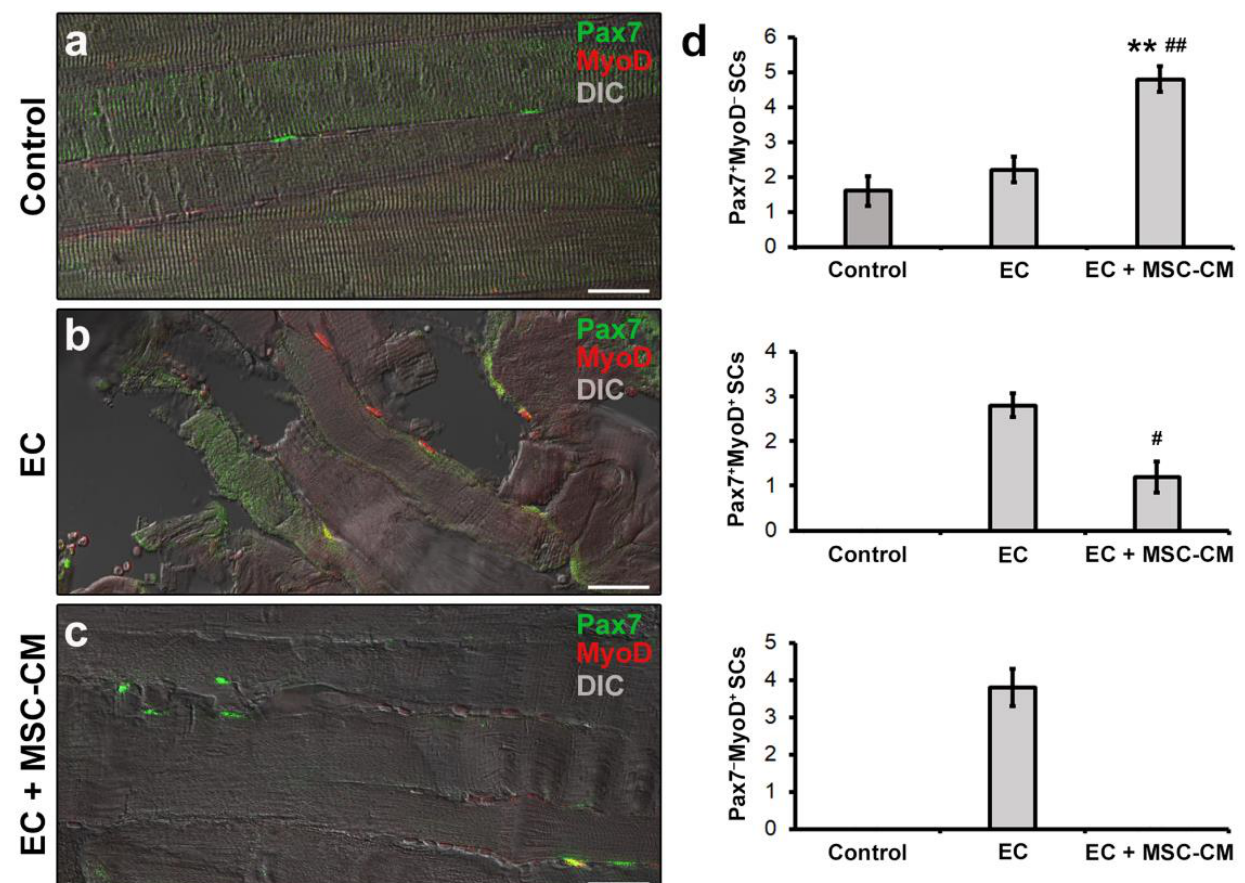
Figure 5. Morphological evaluation of satellite cells (SCs) in formalin-fixed and paraffin-embedded tissue sections from control EDL muscles, EDL muscles damaged by ex vivo forced eccentric contraction (EC) and EDL muscles damaged by EC in the presence of bone marrow-mesenchymal stromal cell (MSC) conditioned medium (EC + MSC-CM). ( a–c ) Representative superimposed confocal immunofluorescence and differential interference contrast (DIC, grey) images of muscle tissue sections immunostained with antibodies against the SC marker Pax7 (green) and the SC activation marker MyoD (red). Quiescent SCs or SCs likely contributing to replenish SC basal pool are identifiable as Pax7 + /MyoD − (green), tissue damage-activated SCs as Pax7 + /MyoD + (yellow), and SCs committed into the myogenic program as Pax7 − /MyoD + (red). Images are representative of at least 3 sections from each of 4 control, 4 EC and 4 EC + MSC-CM muscles. Scale bars = 25 μm. ( d ) Quantitative analysis of Pax7 + /MyoD − , Pax7 + /MyoD + and Pax7 − /MyoD + SCs in the different experimental conditions. Values are mean ± SEM. ** p < 0.01 vs. control; # p < 0.05 and ## p < 0.01 vs. EC.